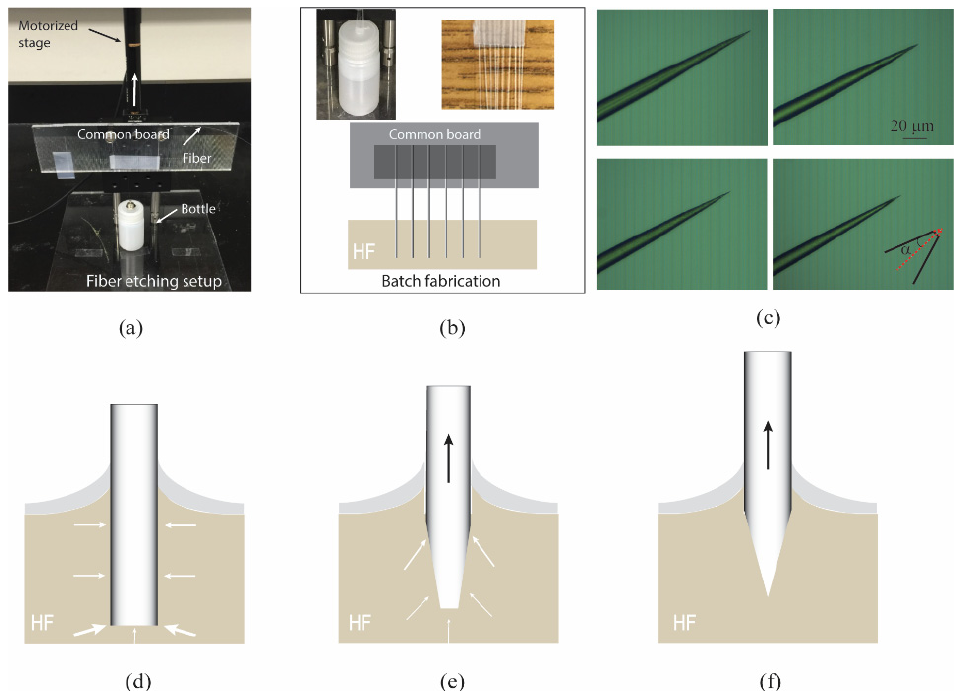
Figure 1. The fiber pulling assisted tubeless chemical etching setup for ( a ) a single fiber and ( b ) a batch of fibers. Either a single fiber ( a ) or a batch of fibers ( b , upper right inset) were attached to a motorized stage via a plastic common board. The attached fiber or a batch of fibers were inserted into an HF − filled plastic bottle ( b , upper left inset) and moved upwards at a constant speed. The value of the speed, which is related to the etching time and determines the opening angle ( α , bottom right of ( c )) and surface quality of the fiber, was optimized as 1 µ m/s and 60 min, respectively. For the batch fiber etching, the adjacent fibers are separated at a distance of ~1 mm. ( c ) Typical microscopic images of multiple fiber tapers resulting from a single fabrication batch. ( d – f ) The fiber tip formation by chemical etching. ( d – f ) The schematics of the initial, intermediate, and final stages of the etching process of a single optical fiber, respectively. The white arrows point to the directions of the etching. The arrow thickness represents the etch rate with thicker ones for faster rates. The black arrows represent the moving direction of the fiber, which was controlled by the motorized stage, during the etching process .